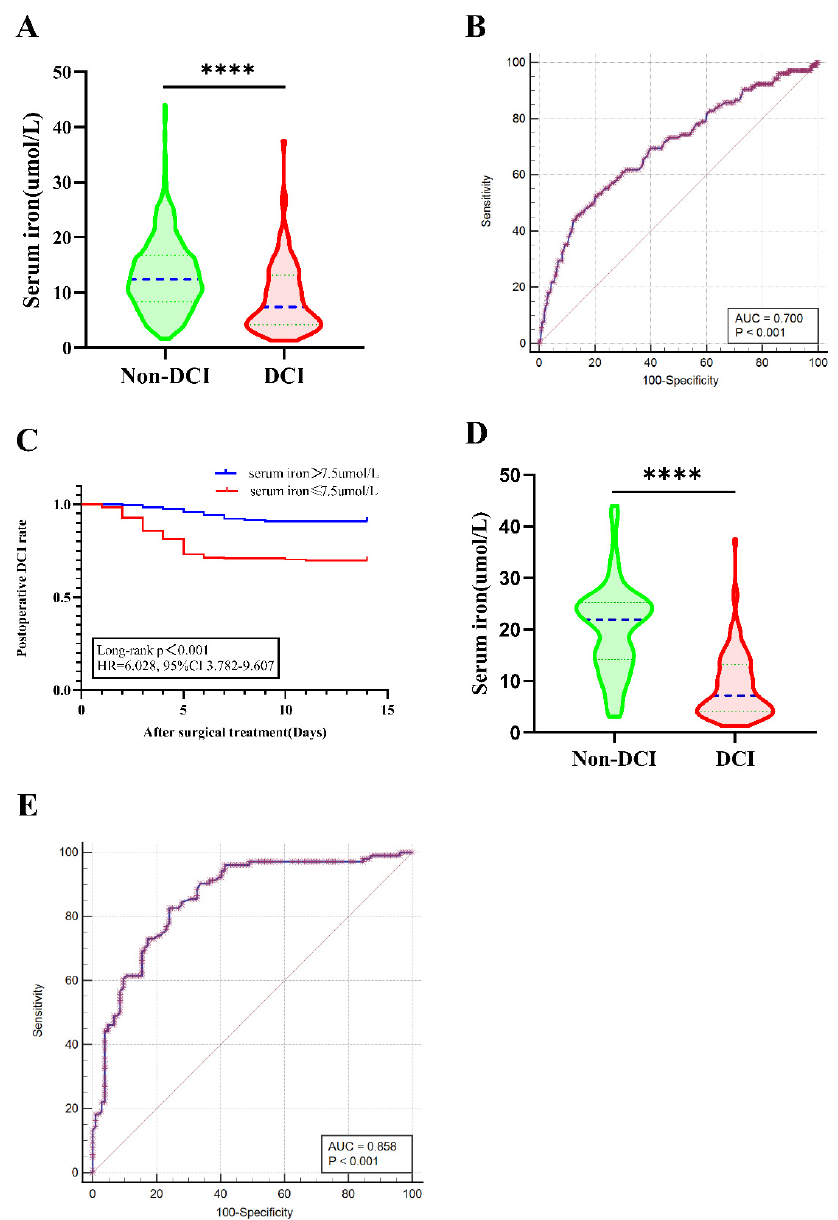
Figure 3. Associations between serum iron levels and DCI. ( A ) Comparison of serum iron levels in aSAH patients between DCI and non–DCI. ( B ) ROC curve analysis of serum iron as a predictor in aSAH patients for DCI gave an AUC value of 0.7 and an optimal cut-off value of 7.5 μ mol/L with a corresponding of sensitivity at 52.38% and specificity of 79.68%. ( C ) Kaplan–Meier curve of the 14- day postoperative DCI–rate of aSAH by serum iron level. Log-rank test revealed that patients with serum iron ≤ 7.5 μ mol/L had a significantly worse postoperative DCI than patients with >7.5 μ mol/L (HR = 6.028, 95% CI 3.782–9.607, p < 0.001). ( D ) Comparison of serum iron levels in aSAH patients between DCI and non-DCI after PSM. ( E ) After PSM, the AUC of serum iron level was 0.858 (95% CI 0.803–0.902; p < 0.0001) (Sensitivity = 82.69%; Specificity = 75.96%) for postoperative DCI based on a cut–off value of 14.1 μ mol/L. Data were shown for violin plots in panel A and panel D. Groups were compared using Student’ t -test. (****: p ≤ 0.0001) AUC: area under the curve; aSAH: aneurysmal